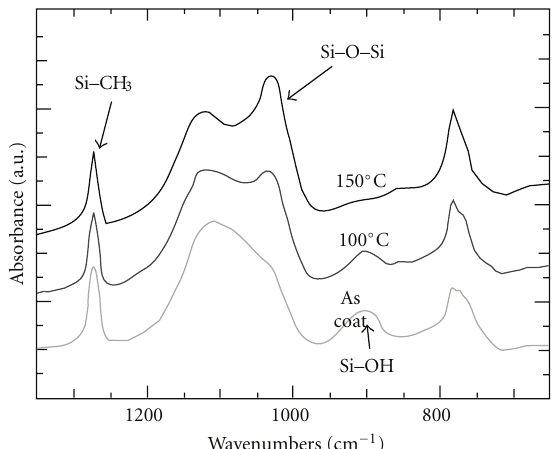
Figure 4: FT-IR spectra of PMSQ films before and after thermal treatment at 100 ◦ C and 150 ◦ C for 1h in air.